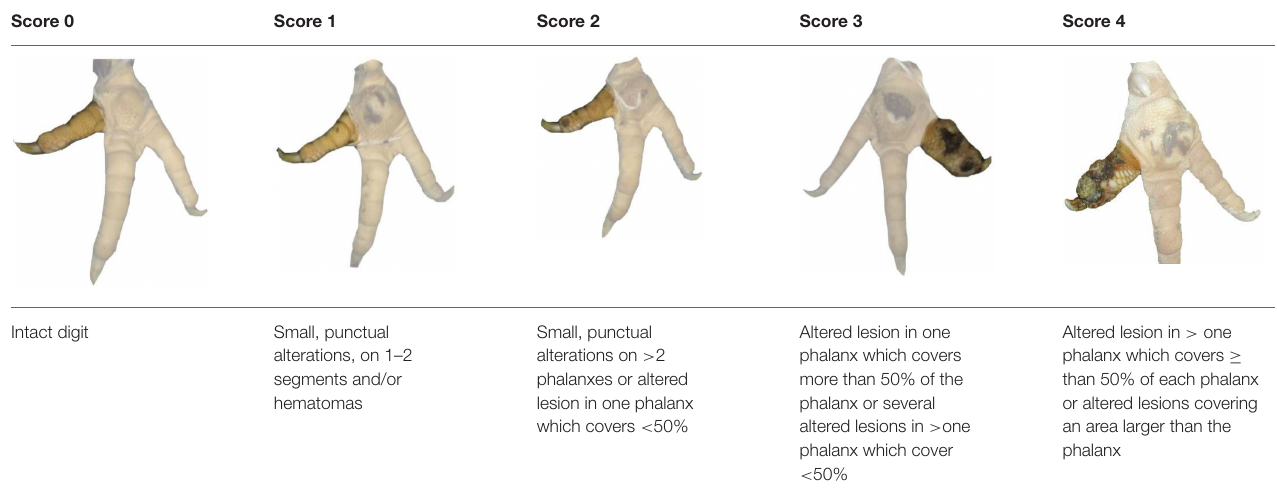
TABLE 2 | Scoring system for the digital pads: Altered lesion on the digital pad.